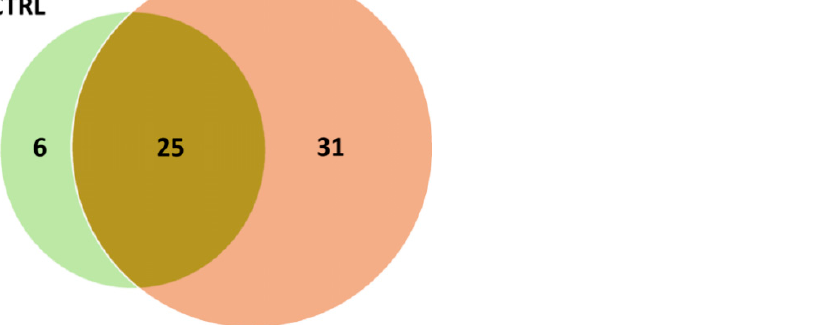
Figure 3. Venn diagram depicting the distribution of putative adducts in the two conditions (CTRL vs. HF).